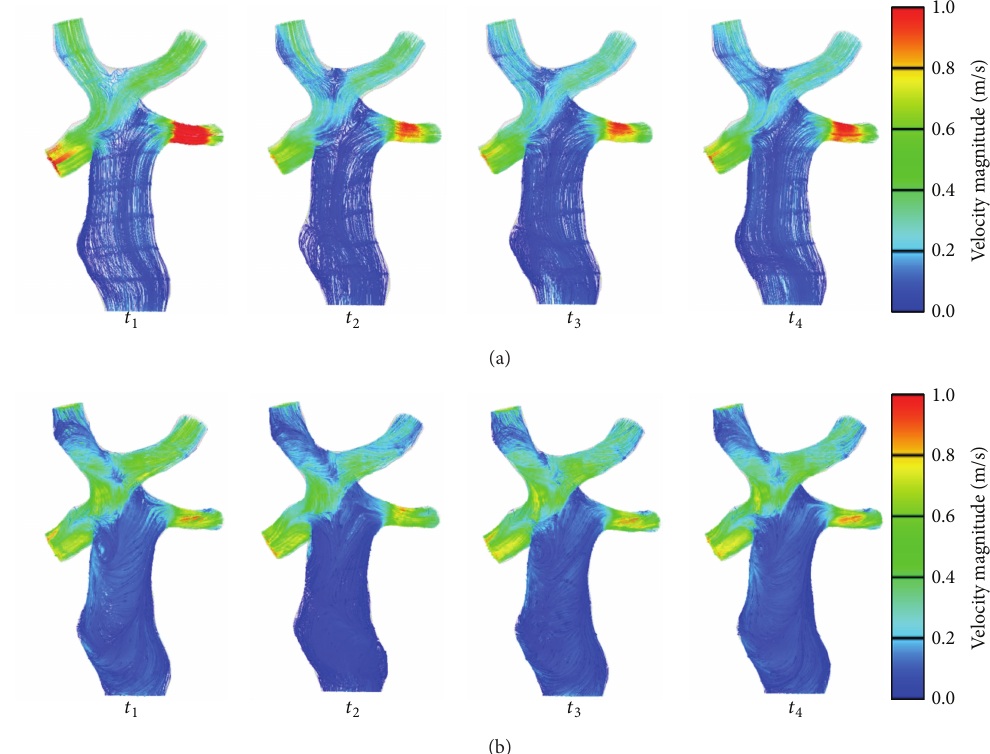
Figure 9: Results of streamlines (Condition II (a) and Condition I (b)).